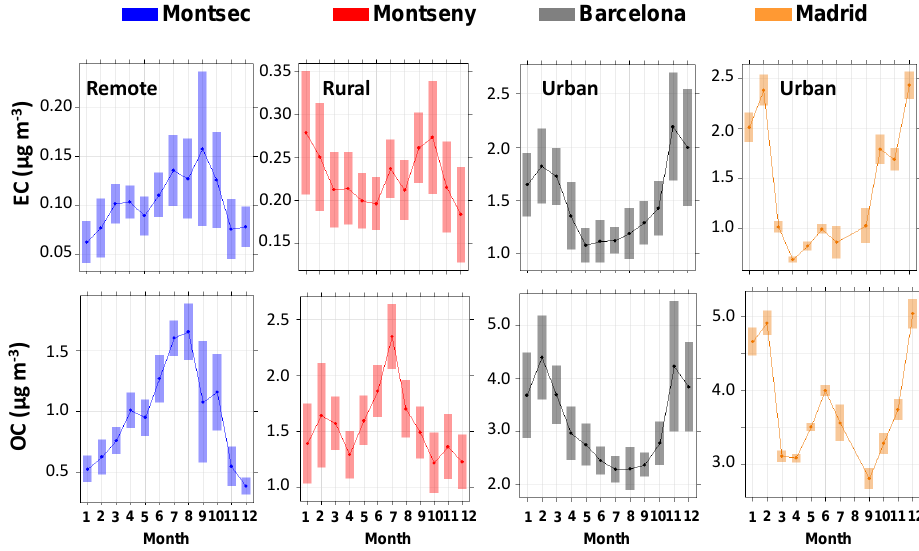
Figure 8. Monthly mean OC and EC concentrations in PM2.5 at Montsec (remote), Montseny (rural), Barcelona and Madrid (urban background and traffic sites). Bars represent 95 % confidence intervals.